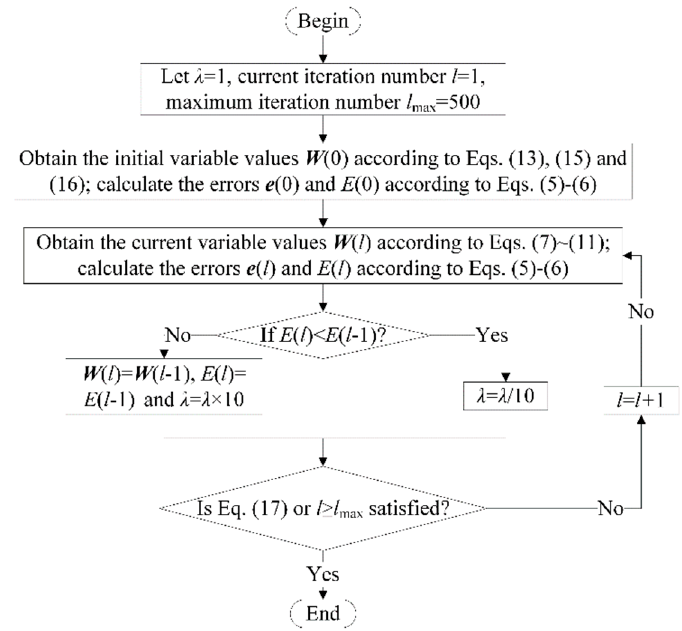
Figure 2. Flowchart of the proposed algorithm.